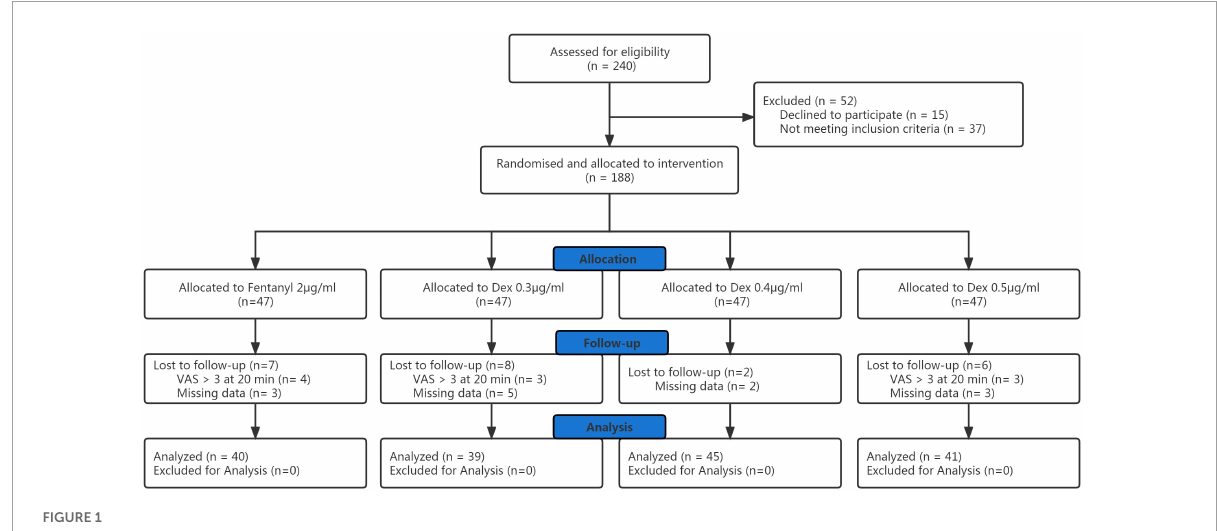
FIGURE1 CONSORT